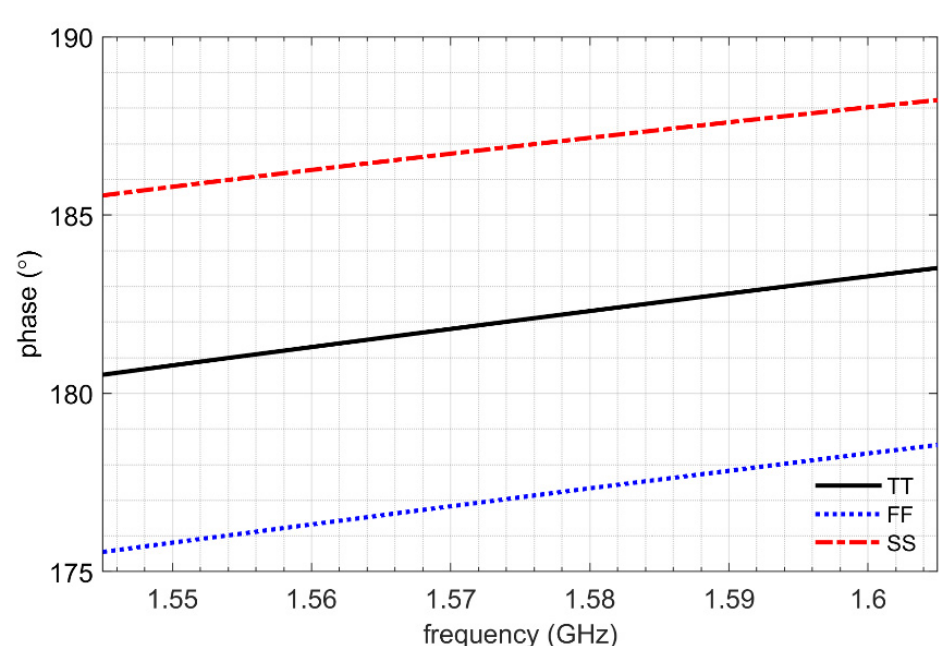
Figure 12. Phase shift between “outp” and “outn” outputs in a typical case (TT) and two PVT corner cases. SS case: slow process corner (slow transistors, high capacitances, high resistances), temperature: 105 °C, VDD = 1.35 V. FF case: fast process corner (fast transistors, low capacitances, low resistances), temperature: − 40 °C, VDD = 1.65 V. TT case: typical process corner, temperature: 27 °C, VDD = 1.5 V.